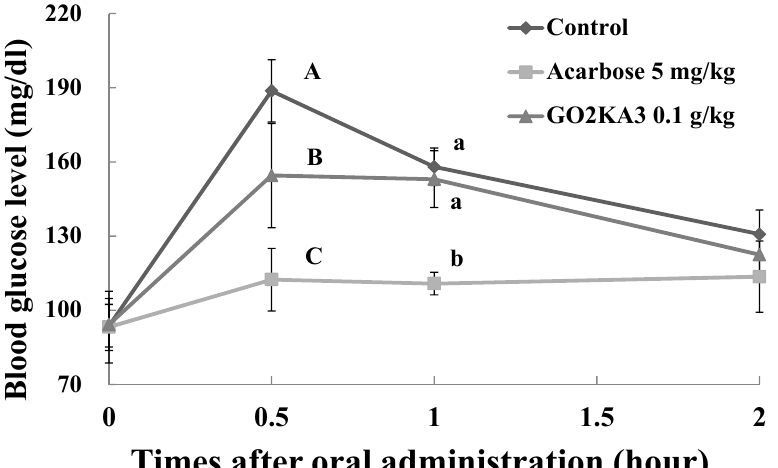
Figure 5. Effect of GO2KA3 on sucrose loading test. After fasting for 24 h, six-week-old, male SD rats were orally administered with sucrose solution (2.0 g/kg) with or without samples (GO2KA3; MW > 10,000 Da, positive control; Acarbose). Each point represents mean ± S.D. ( n = 5). A − C Different corresponding letters indicate significant differences ( p < 0.05) at 0.5 h by Duncan’s test. a − c Different corresponding letters indicate significant differences ( p < 0.05) at 1.0 h by Duncan’s